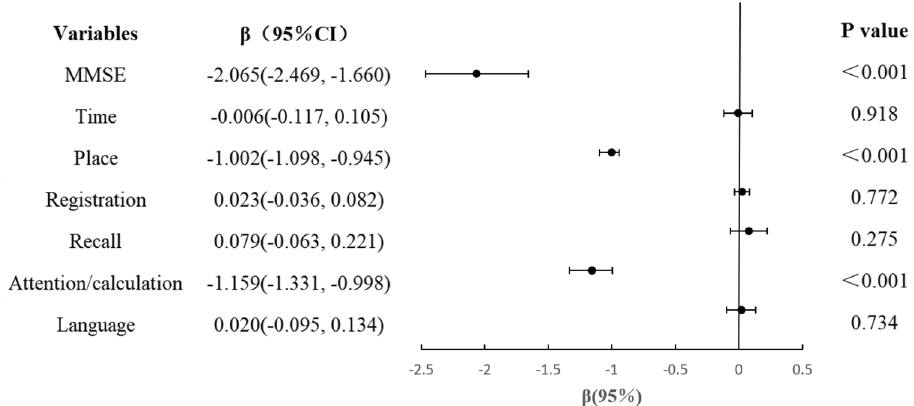
Figure 1. Linear regression between time restricted feeding and cognitive status in the study sample (time feeding restricted to 10 h vs. no restriction). * Multiple linear regression model, with cognitive status as the dependent variable. CI confidence interval. The results are adjusted for age, sex, BMI, IADL, illiterate, widowed, living alone, farming, smoking, drinking, night-time feeding, IPAQ, type-2 diabetes, hypertension, dyslipidemia, stroke, heart disease, and cancer. * MMSE Mini-mental State